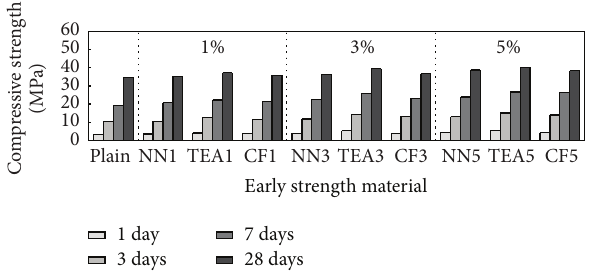
Figure 7: Compressive strength of concrete in relation to the type and amount of early strength material.